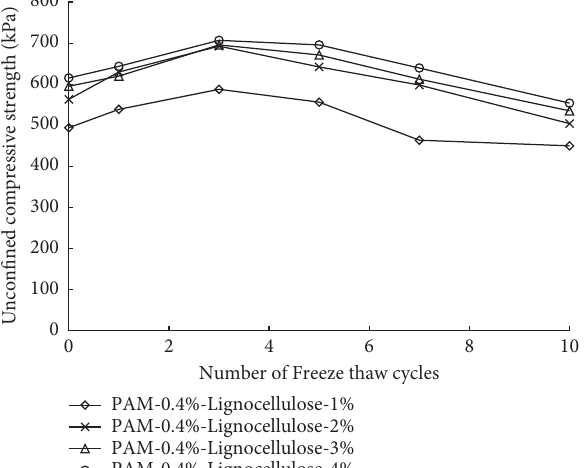
Figure 22: Changes of unconfined compressive strength of PAM and lignocellulose-stabilized specimens with freeze-thaw